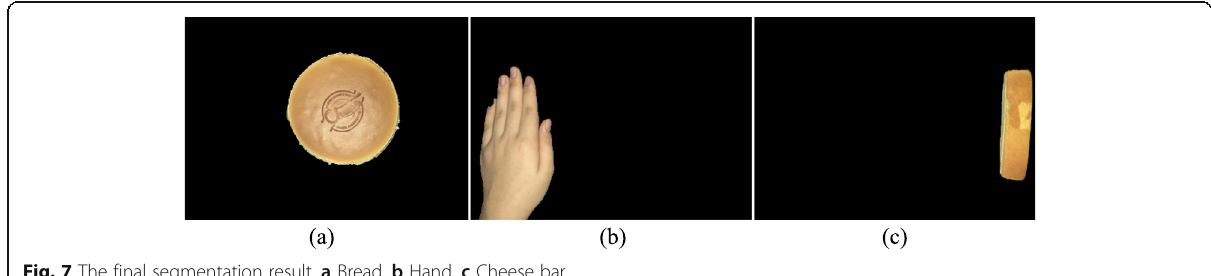
Fig. 7 The final segmentation result. a Bread. b Hand. c Cheese